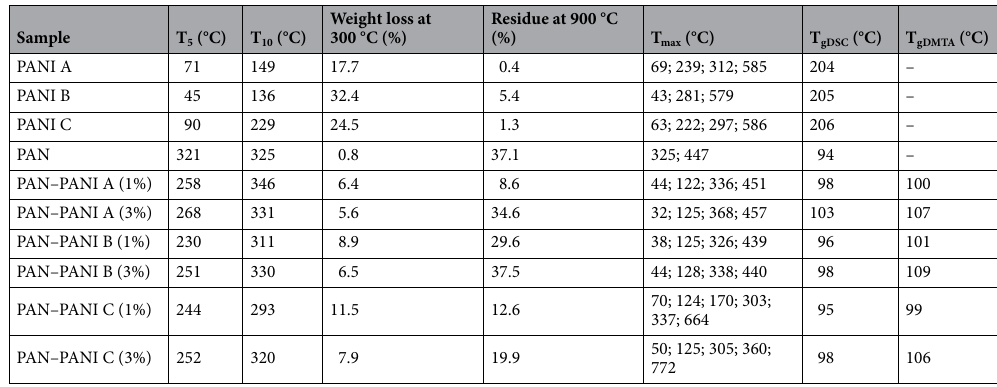
Table 3. Thermal properties of starting polymers and conductive composites. T 5 and T 10 represent the temperatures of 5 and 10% weight loss, T max is the temperature of the maximum decomposition rate as determined by DTA, T gDSC is the glass transition temperature by DSC, and T gDMTA is the glass transition temperature by DMTA.